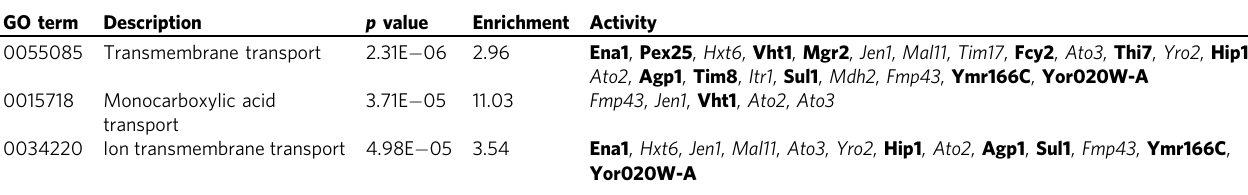
Table 1 Enrichment for proteins whose abundance changes rhythmically across the YRO reveals the importance of membrane transport.